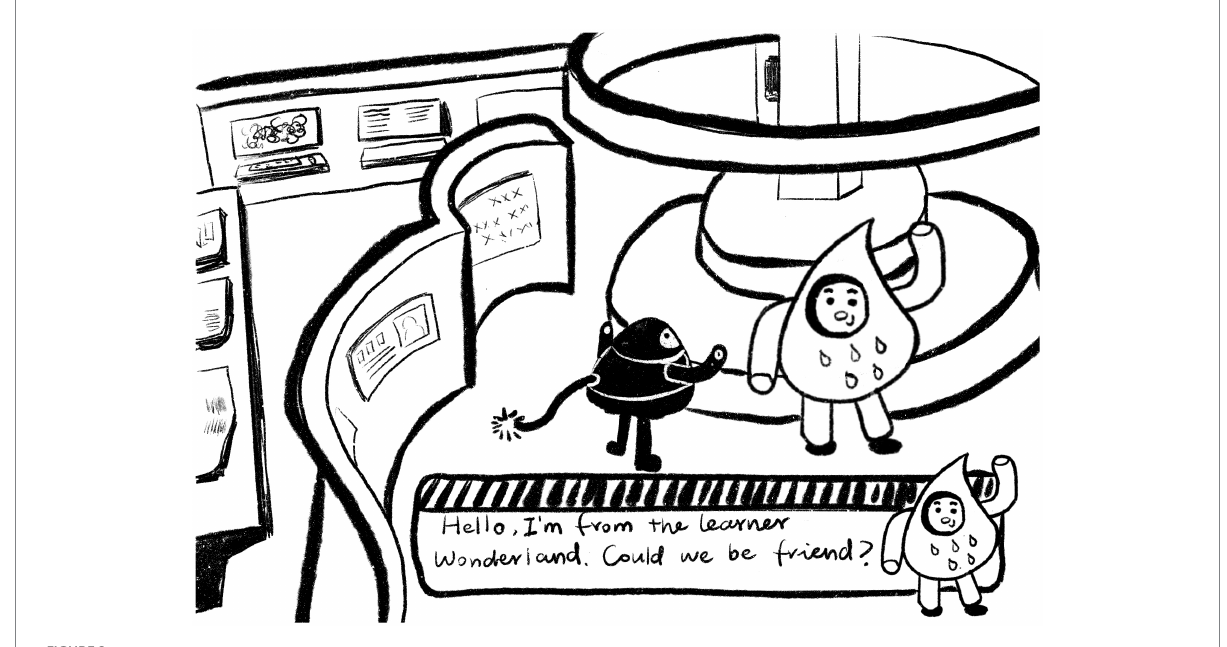
FIGURE 2 Associating non-player characters (NPCs) with other